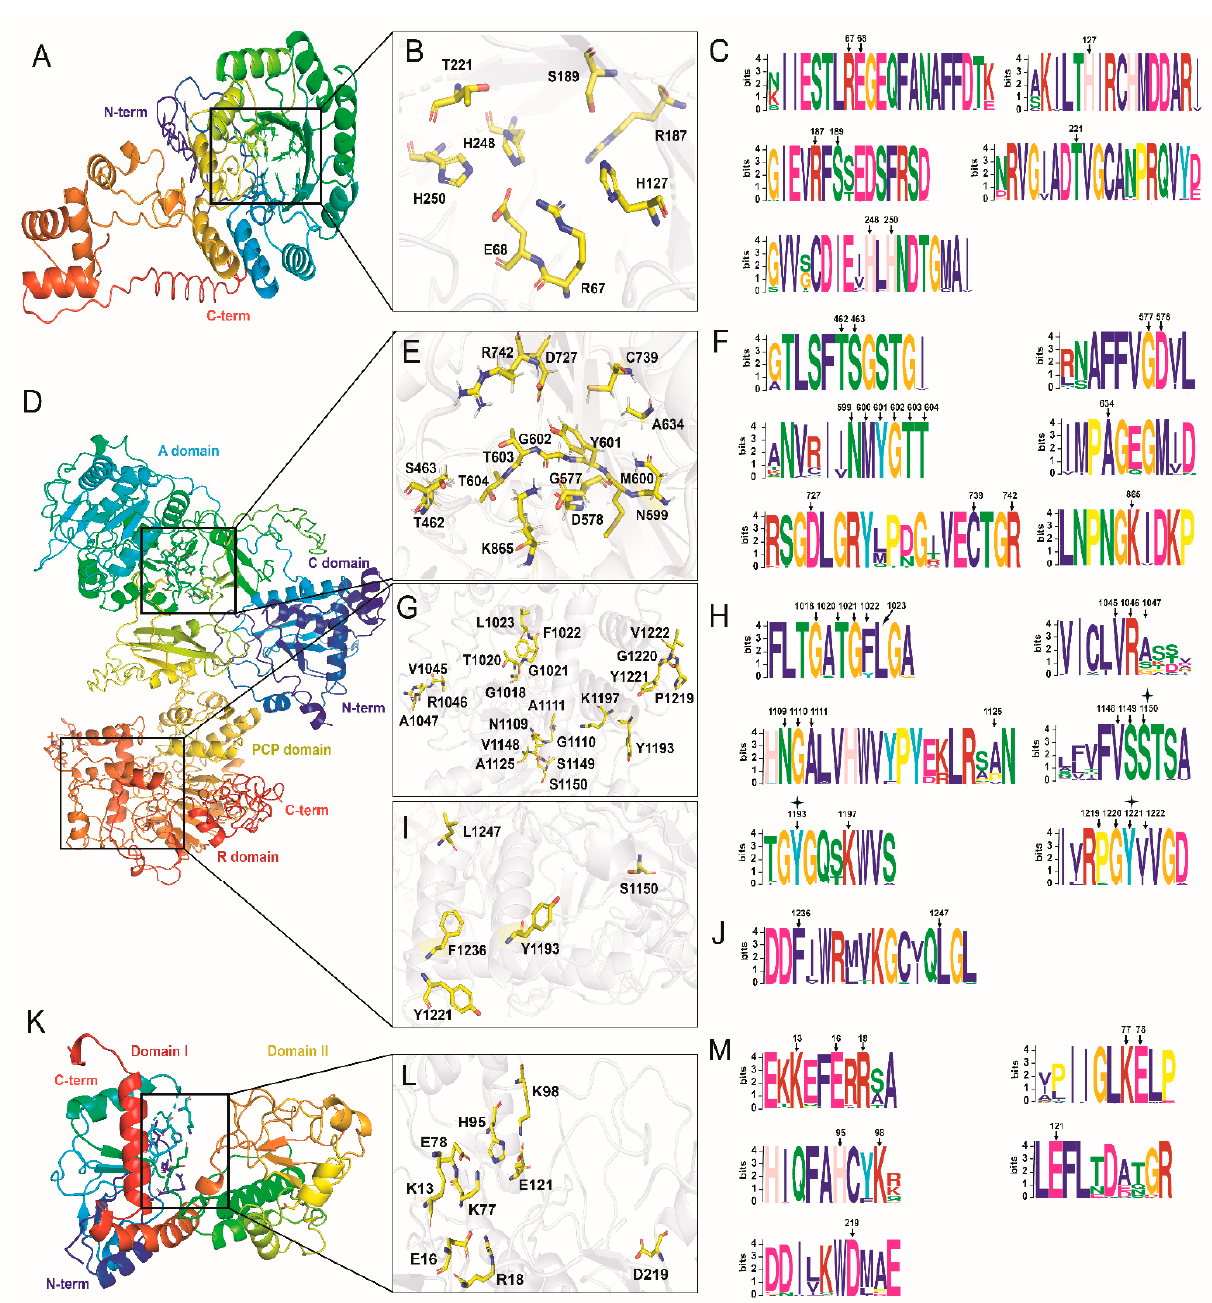
Figure 6. Prediction of 3-D structures and interdomain interactions of substrate molecules trapped in enzymatic progress of HCS, AAR, and SDH. ( A ) 3-D structure of FvHCS in F. velutipes , ( B ) interactional binding sites of substrate molecule in HCS, ( C ) conservative motif of interactional binding sites in homologous sequences of HCS by MEME, ( D ) 3-D structure of LbAAR in L. bicolor, ( E ) interactional binding sites of AMP molecule in AAR, ( F ) conservative motif of interactional binding sites of AMP in homologous sequences of AAR by MEME, ( G ) interactional binding sites of NAD( P ) in AAR, ( H ) conservative motif of interactional binding sites of NAD(P) in homologous sequences of AAR by MEME, ( I ) interactional binding sites of putative substrate molecule in AAR, ( J ) conservative motif of interactional binding sites of putative substrate molecule in homologous sequences of AAR by MEME, ( K ) 3 ‐ D structure of FvSDH in F. velutipes , ( L ) interactional binding sites